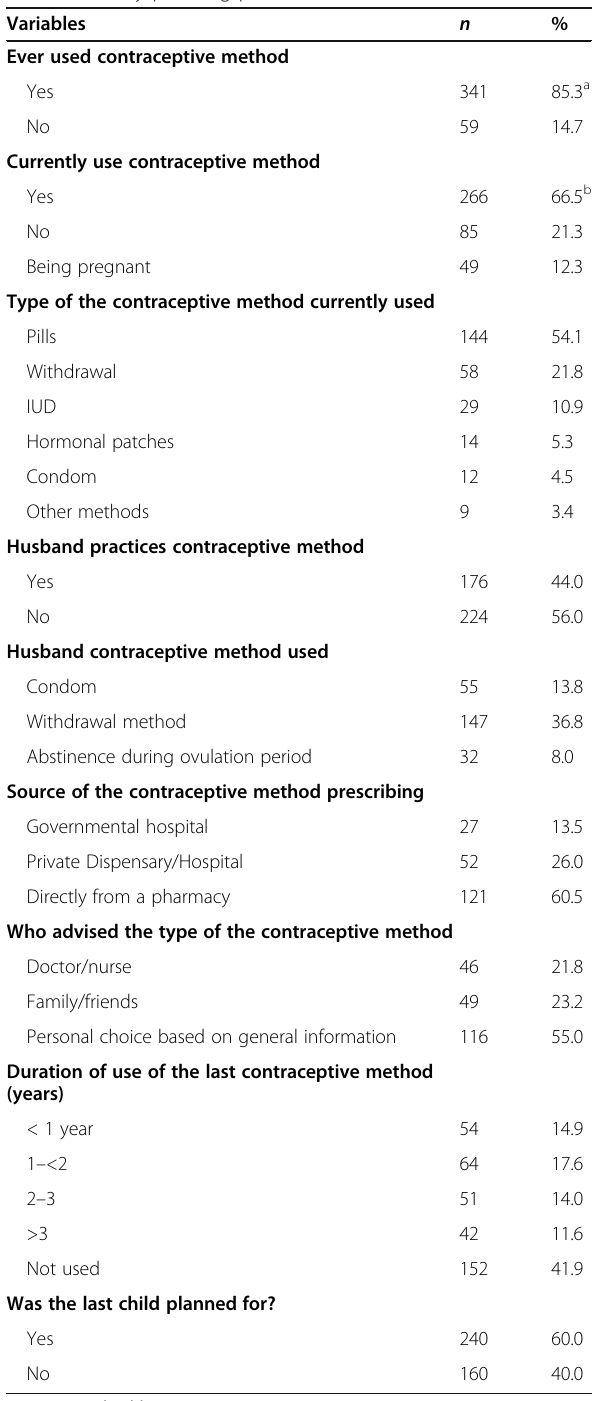
Table 3 Family planning